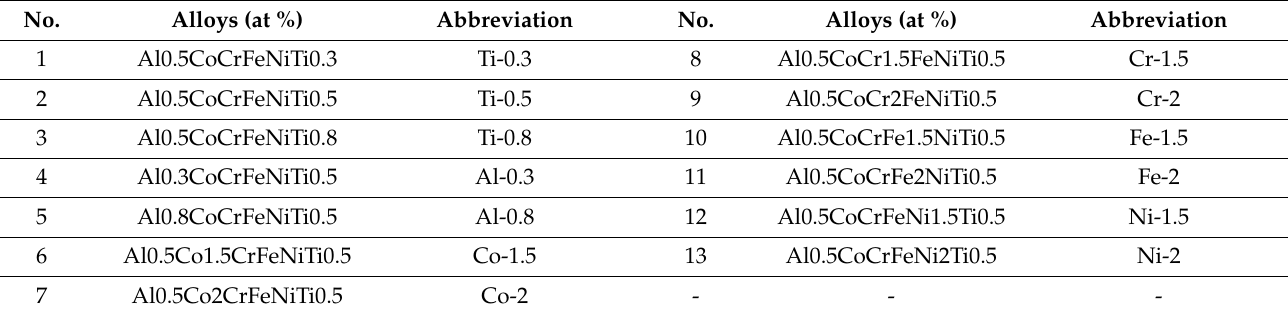
Table 1. Elemental composition of AlCoCrFeNiTi HEAs.